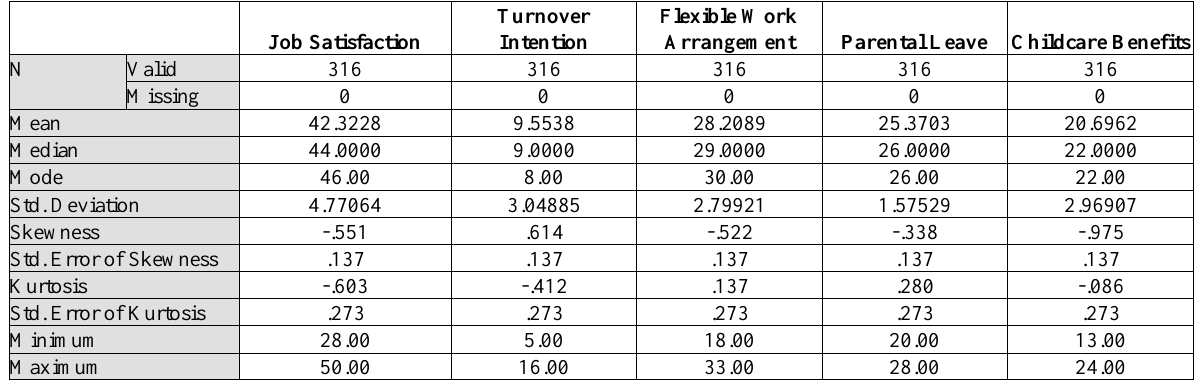
Table 1. Frequency Analysis for Each